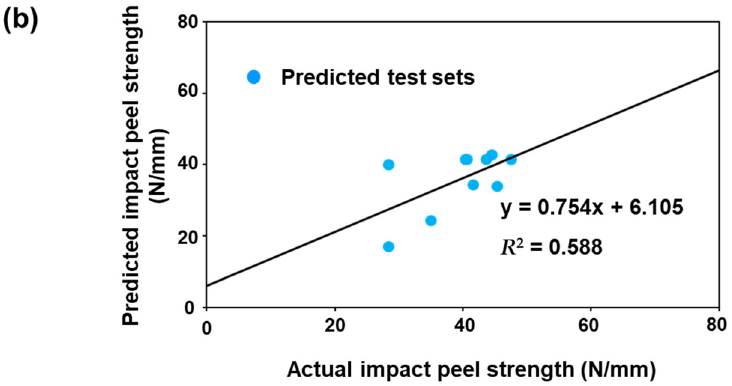
Figure 5. ( a ) Correlation analysis of the predicted lap shear strength by ANN with the actual lap shear strength and the ( b ) correlation of the predicted impact peel strength by ANN with the actual impact peel strength.